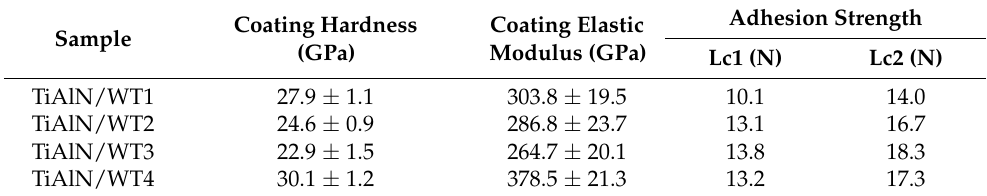
Table 3. Mechanical properties of TiAlN coated cemented